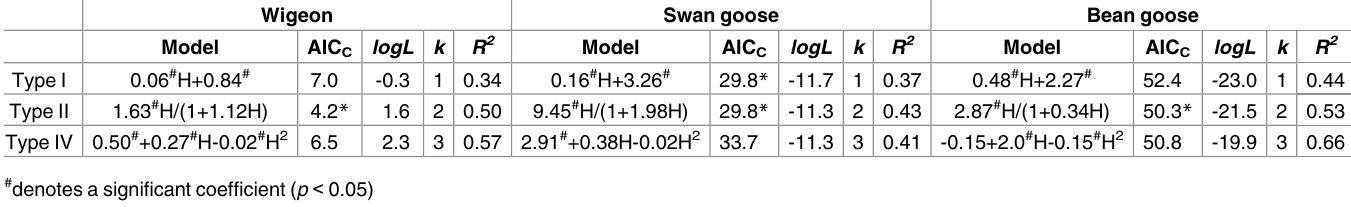
Table 2. Comparing the functional response in relation to sward height based on nitrogen intake rate (mg/min). Type I (linear), Type II, and Type IV (quadratic). AIC C values were used to decide upon the best fitting model. H = Swards height (cm).